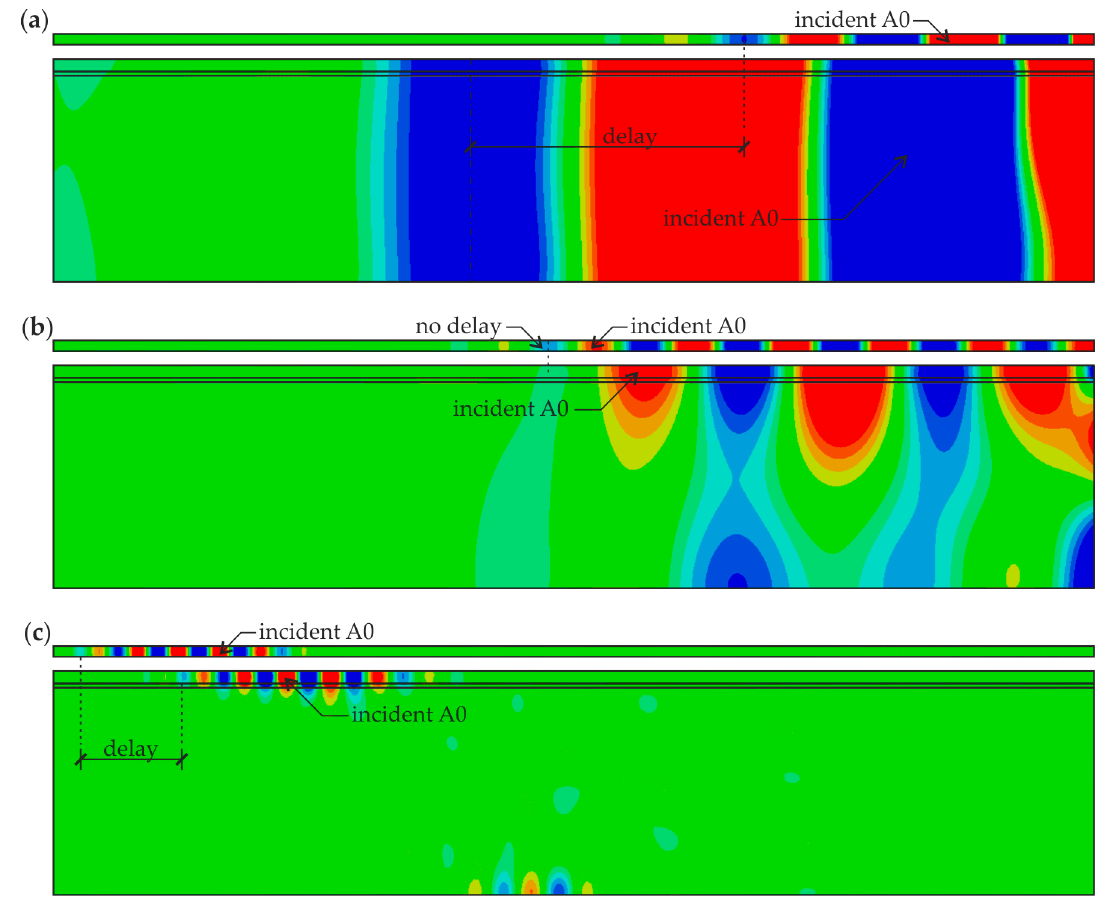
Figure 7. Numerical wave fields in 2-D finite element method (FEM) models of specimens #1 and #5 ( t = 0.17 ms) for different excitation frequencies: ( a ) 10 kHz; ( b ) 23 kHz; and ( c ) 100 kHz.